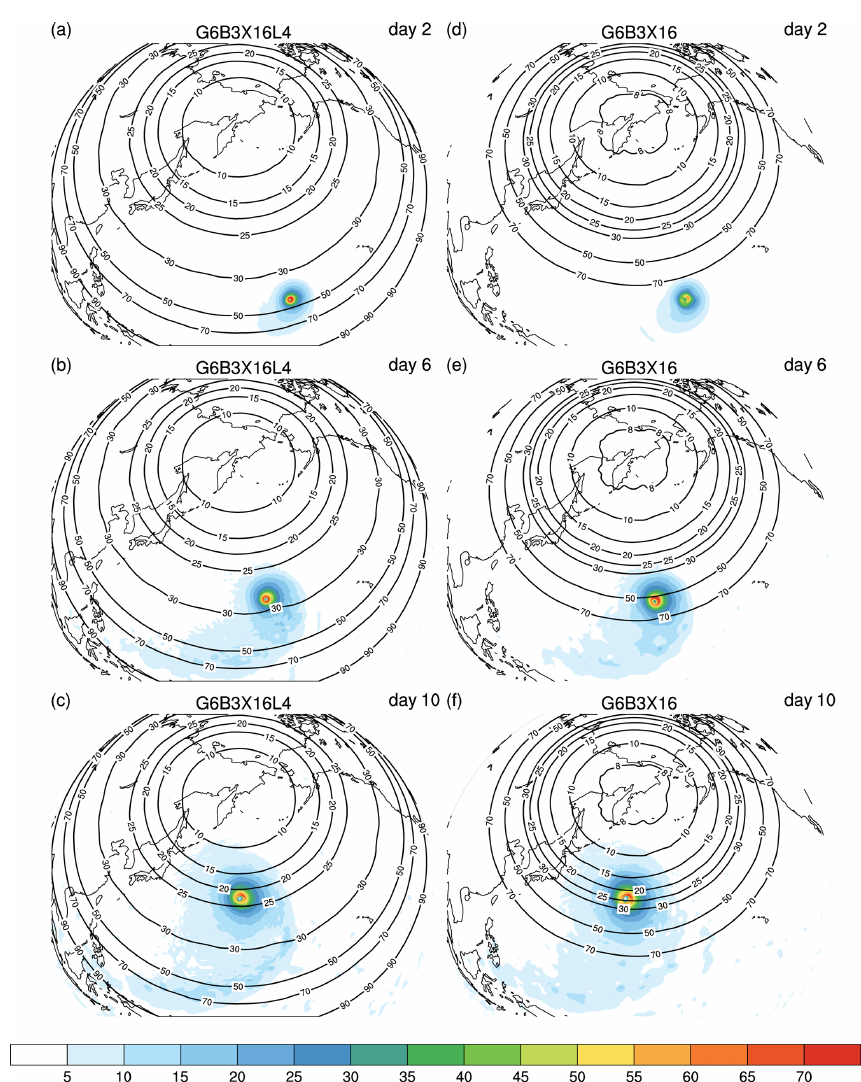
Figure 15. The same tests as in Fig. 13, but the refinement center is rotated to 60 ◦ N, 165 ◦ E. The left-hand column shows the results on days 2, 6, and 10 on the G6B3X16L4 mesh, and the right-hand column shows the corresponding results on the G6B3X16 mesh. The results are shown for the wind speed (ms − 1 ) at the model level nearest to 850hPa (level